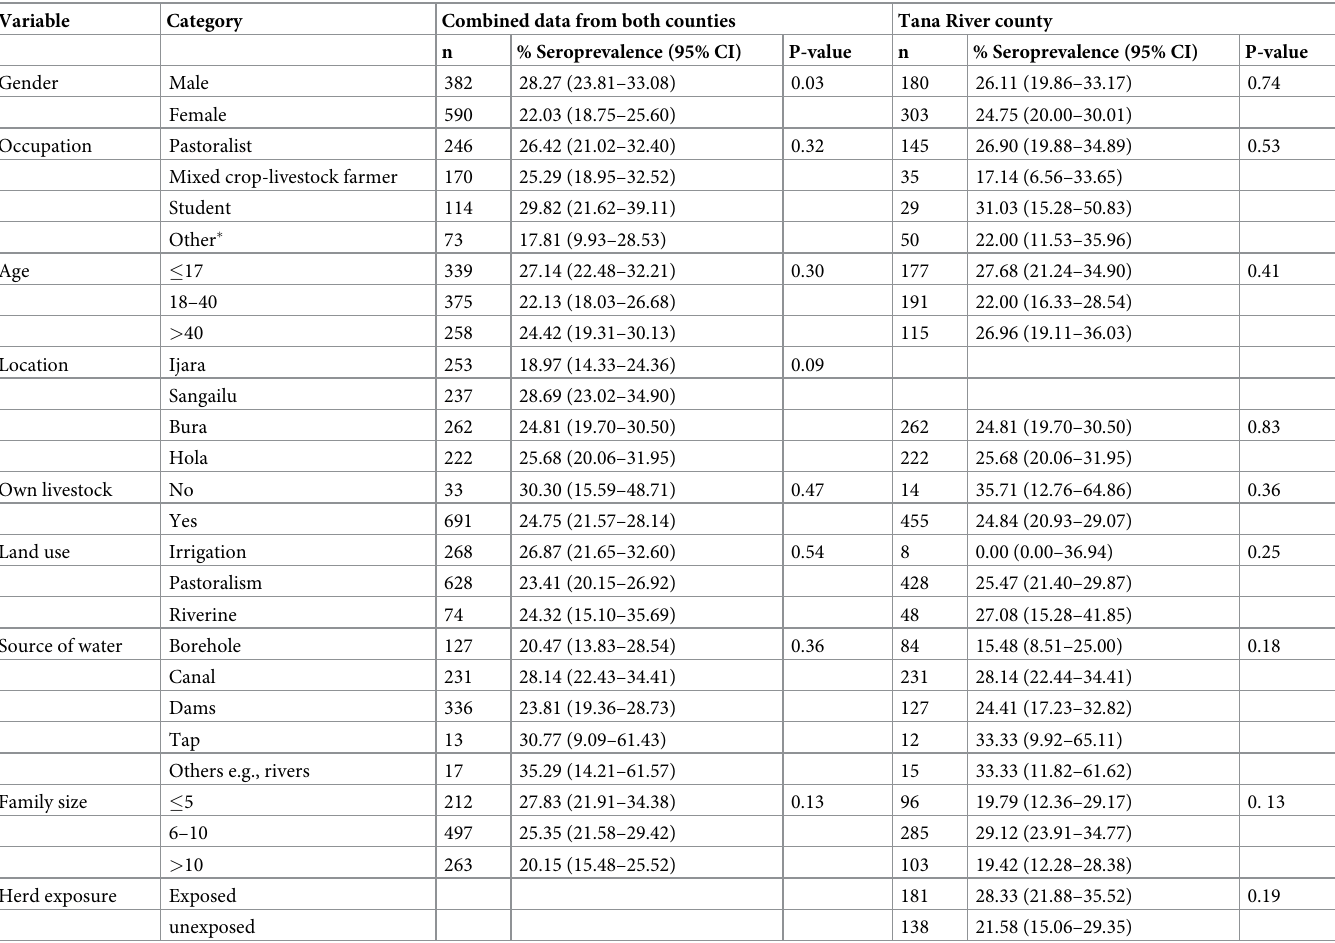
Table 3. Results showing the seroprevalence estimates of C . burnetii in humans based on analysis performed using combined data for all animals from both coun- ties and subset data from Tana River